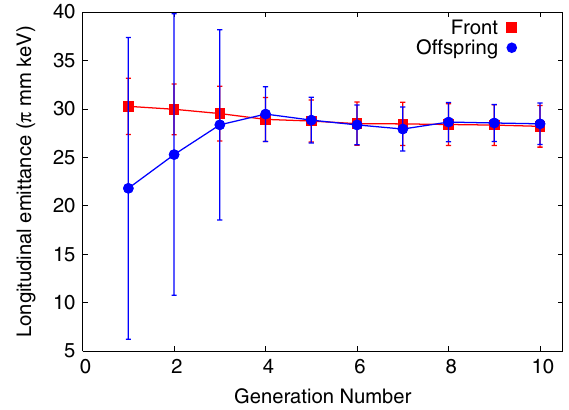
FIG. 26. Average frequency for the Pareto-optimal front and offspring for each generation.